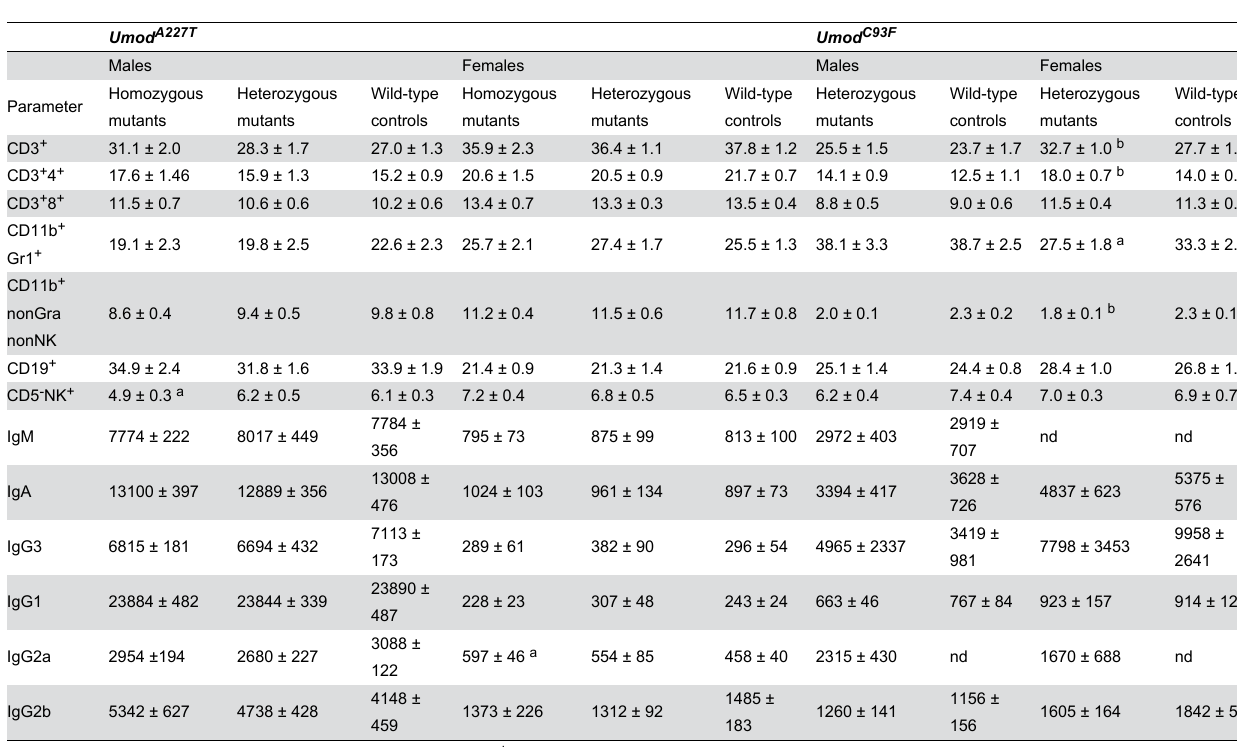
Table 5. Immunology analysis of the lines Umod A227T and Umod C93F